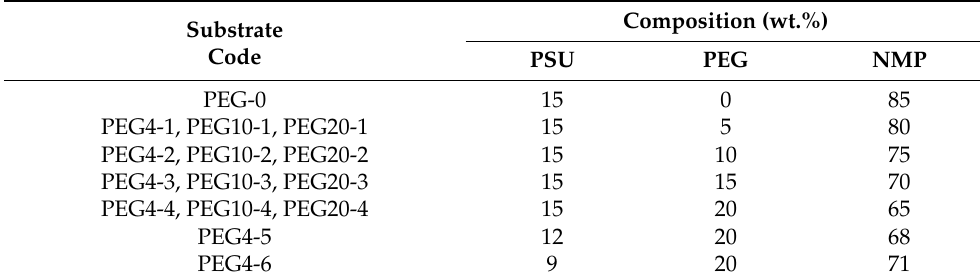
Table 1. Composition of PSU/PEG/NMP casting solutions.